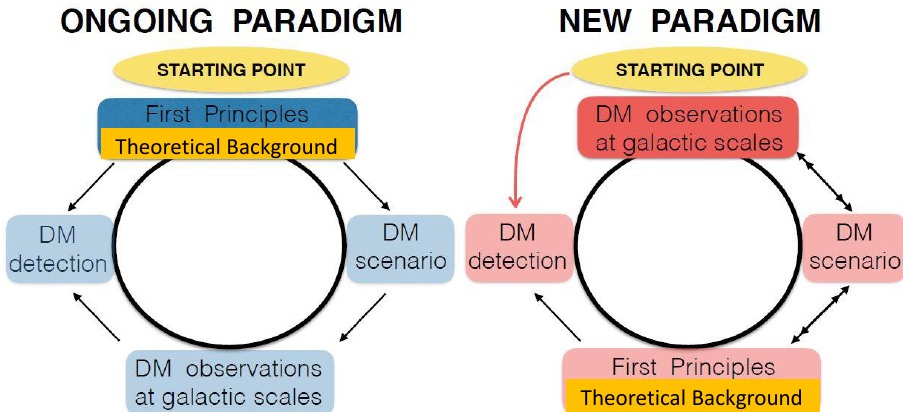
Figure 5. The current and the new Paradigms. Notice the different role of the galactic DM-related